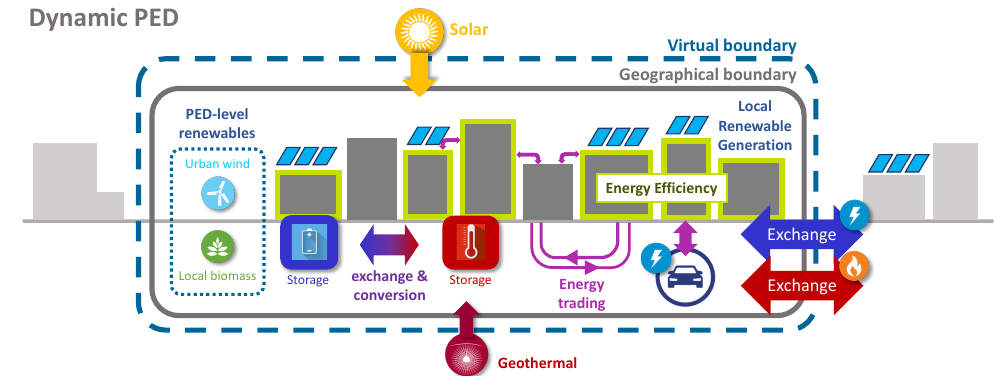
Figure 2. Dynamic PED, principle and system boundaries. Including energy efficiency measures, renewables (solar, PV, wind, biomass, geothermal, small hydropower), waste heat recovery, electric and thermal storage, integration of mobility energy needs (and EVs as batteries), sector coupling between electric and thermal, and exchange with the surrounding